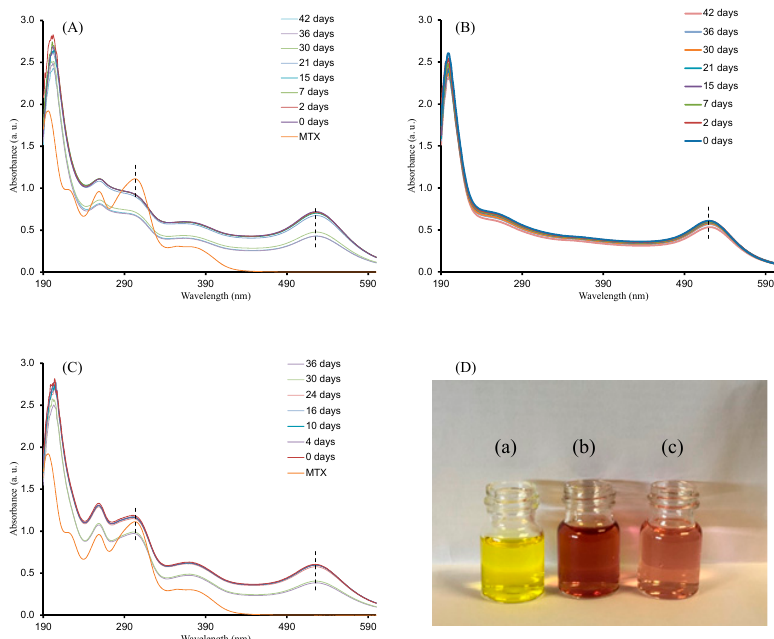
Figure 6. Colloidal stability test for: ( A ) AuNP–MTX400; ( B ) AuNP–MTX200 and ( C ) AuNPs. ( D ) Short-term stability (24 h) in PBS with 10% FBS of HAuCl4 ( a ), AuNP–MTX400 ( b ) and AuNPs ( c ) included as a reference. In all cases, they are not stable when diluted by only phosphate-buffered solution (PBS), while in the presence of fetal bovine serum (FBS), the particles are stable at least for 24 h.